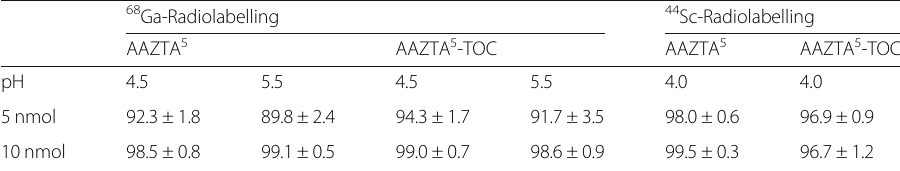
Table 1 Radiolabelling data for [ 68 Ga]Ga-AAZTA 5 , [ 68 Ga]Ga-AAZTA 5 -TOC, [ 44 Sc]Sc-AAZTA 5 , [ 44 Sc]Sc-